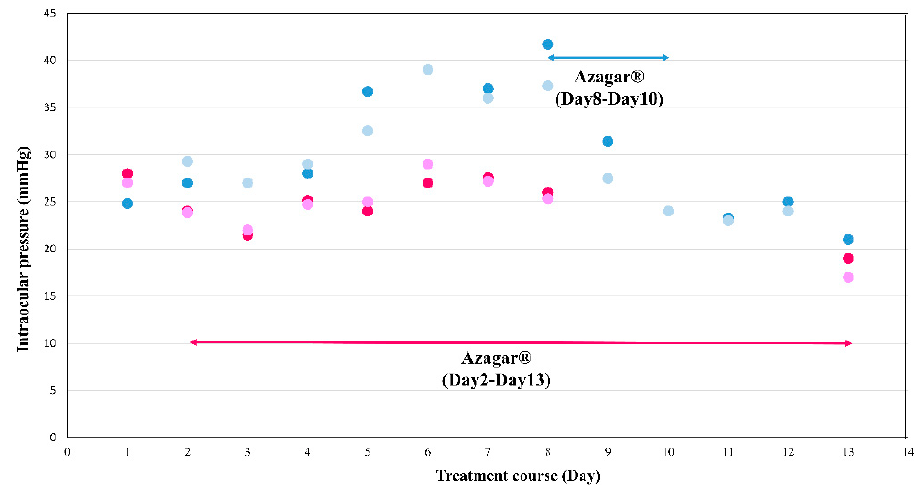
Figure 1. Two courses of intraocular pressure (IOP) fluctuation while using oral dexamethasone (12 mg/m 2 /day). The deep and light blue dots show the IOP change with the use of Azaga ® from Day 8–10, while deep and light red dots show the IOP change with the use of Azaga ® from Day 2–13. IOP = intraocular pressure. Deep blue and deep red dots represented the IOPs of the right eye, while light blue and light red dots represented the IOPs of the left eye.